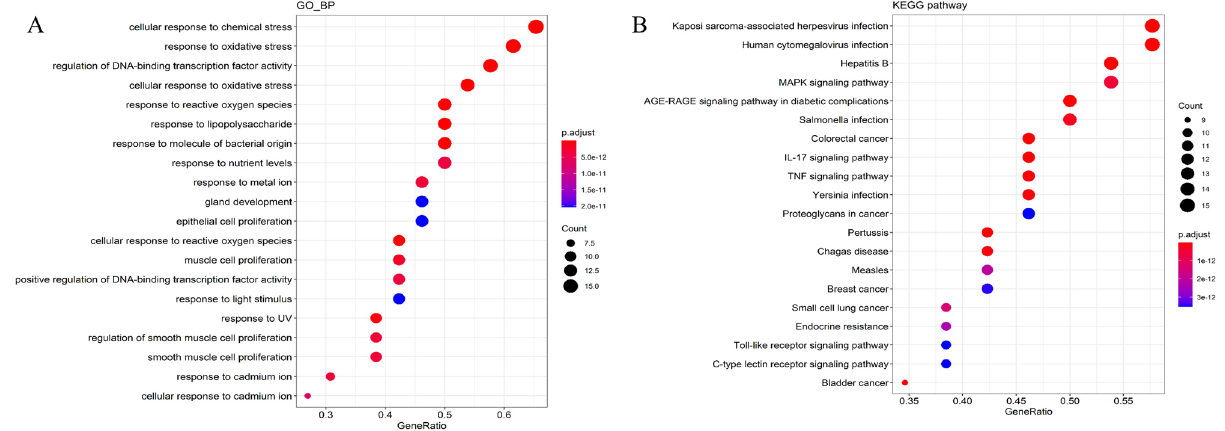
Figure 7. (A) Bubble chart of gene ontology (GO) function enrichment of core targets. (B) Bubble chart of Kyoto Encyclopedia of Genes and Genomes (KEGG) enrichment of core targets.